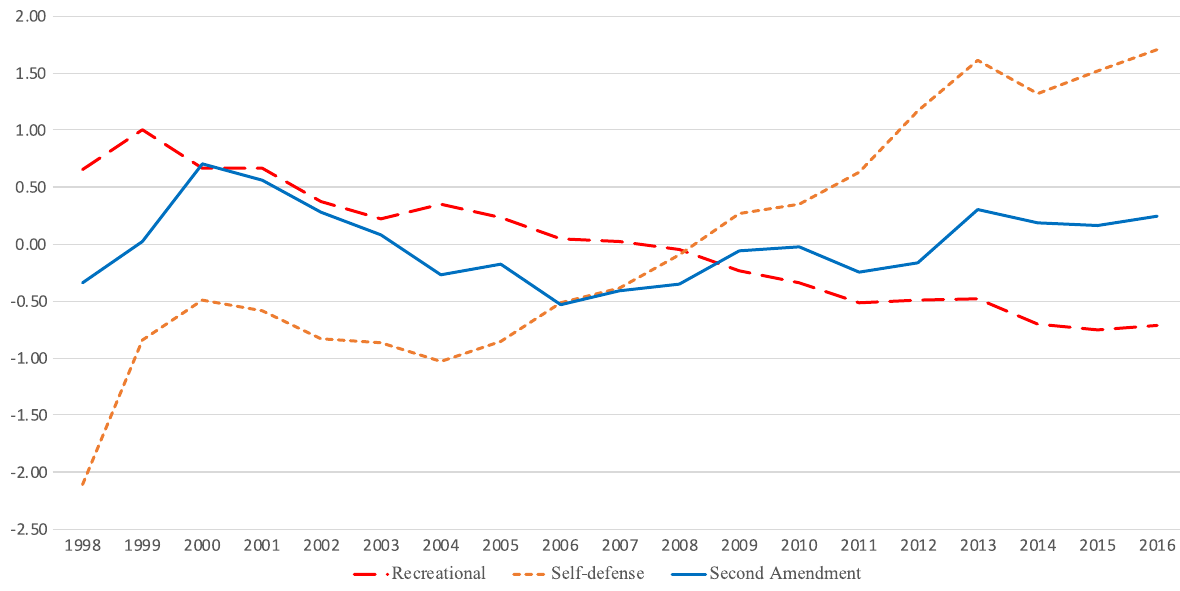
Fig. 1 Changes in cultural elements across the U.S. over time (1998 –